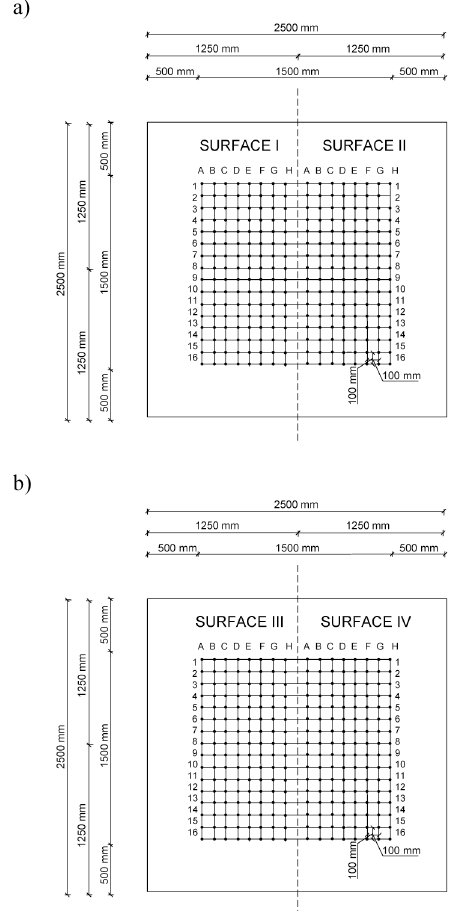
Fig. 3. Division of base layer surface of model test specimen no. 1 (a) and model test specimen no. 2 (b) according to surface preparation method, and arrangement of test points